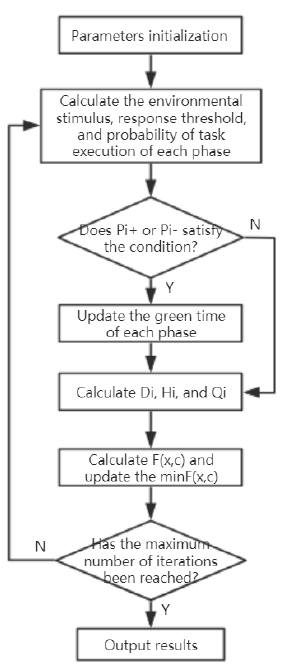
Figure 1. The algorithm calculation process.